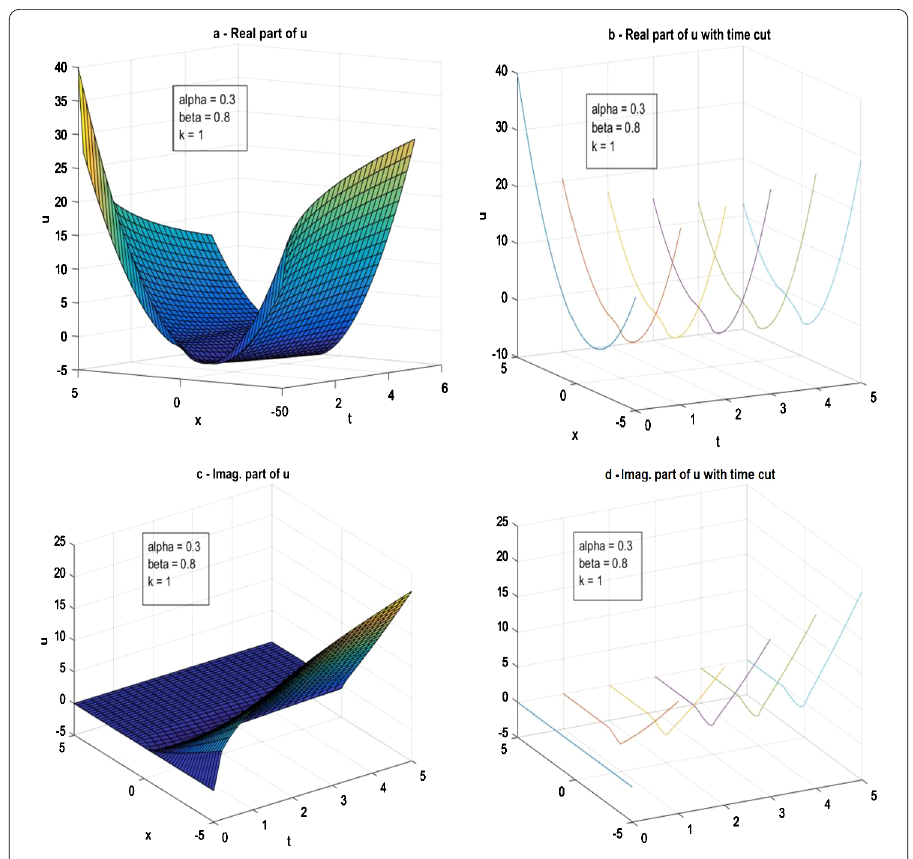
Figure 3 ( a ) and ( c ) are the graphs of the real and imaginary parts of the solution u, where α ( τ ) = 0.3 and β ( τ ) = 0.8. ( b ) and ( d ) are the graphs of the solution u with the time fixed at t = 0,1,2,3,4, and